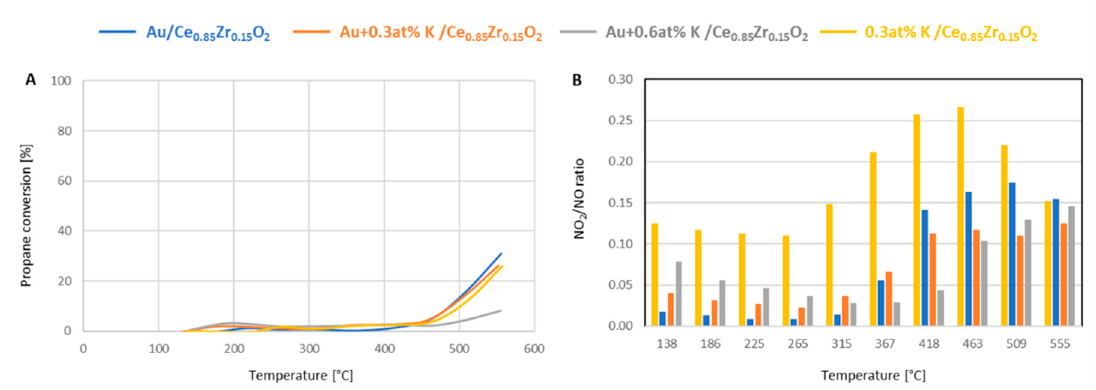
Figure 7. Activity test results: ( A ) Conversion of propane and ( B ) NO 2 / NO ratio in the outlet stream for the gold catalysts and potassium-doped support.